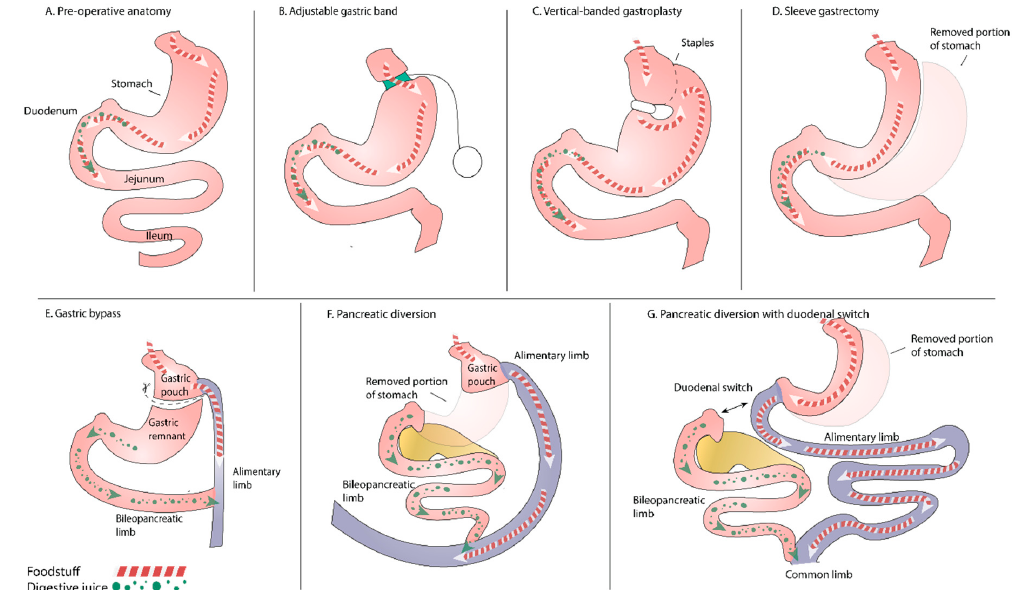
Figure 1. ( A ) Pre-operative anatomy; ( B ) Adjustable gastric band with subcutaneous port; ( C ) Vertical-banded gastroplasty; ( D ) Sleeve gastrectomy; ( E ) Roux-en-Y gastric bypass; ( F ) Biliopancreatic diversion; ( G ) Biliopancreatic diversion with gastric sleeve and duodenal switch.